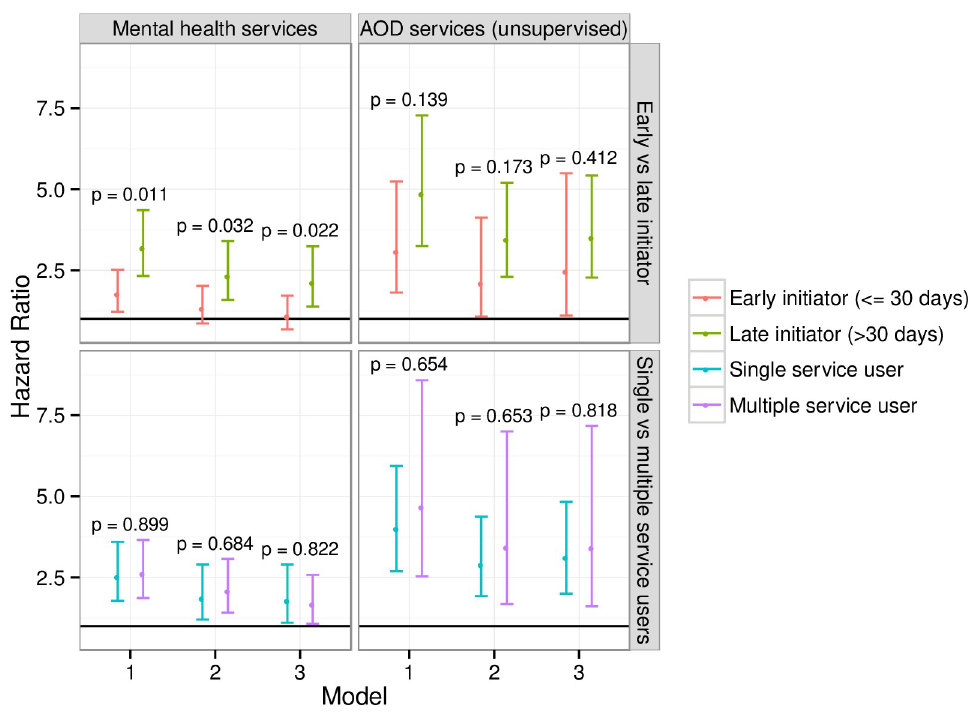
Fig 1. Results of secondary analyses (N = 1,116). The figure shows results from secondary analyses for our Cox proportional hazards models for time to re-incarceration. Early initiators are those who contacted services � 30 days after release from index incarceration; late initiators first contacted services > 30 days after release. Single service users are those who contacted services exactly once; repeat service users contacted services more than once. The p values shown are from Wald tests of the null hypothesis that the pairs of HRs for the breakdowns of each exposure are